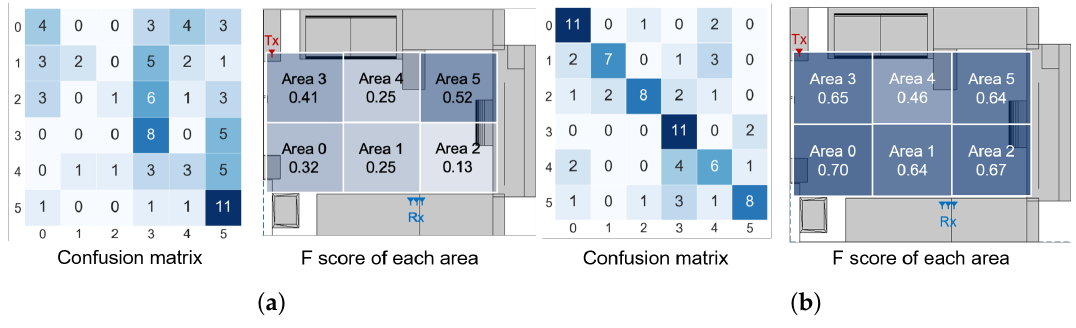
Figure 14. Classification result. ( a ) Existing method. ( b ) Proposed method.